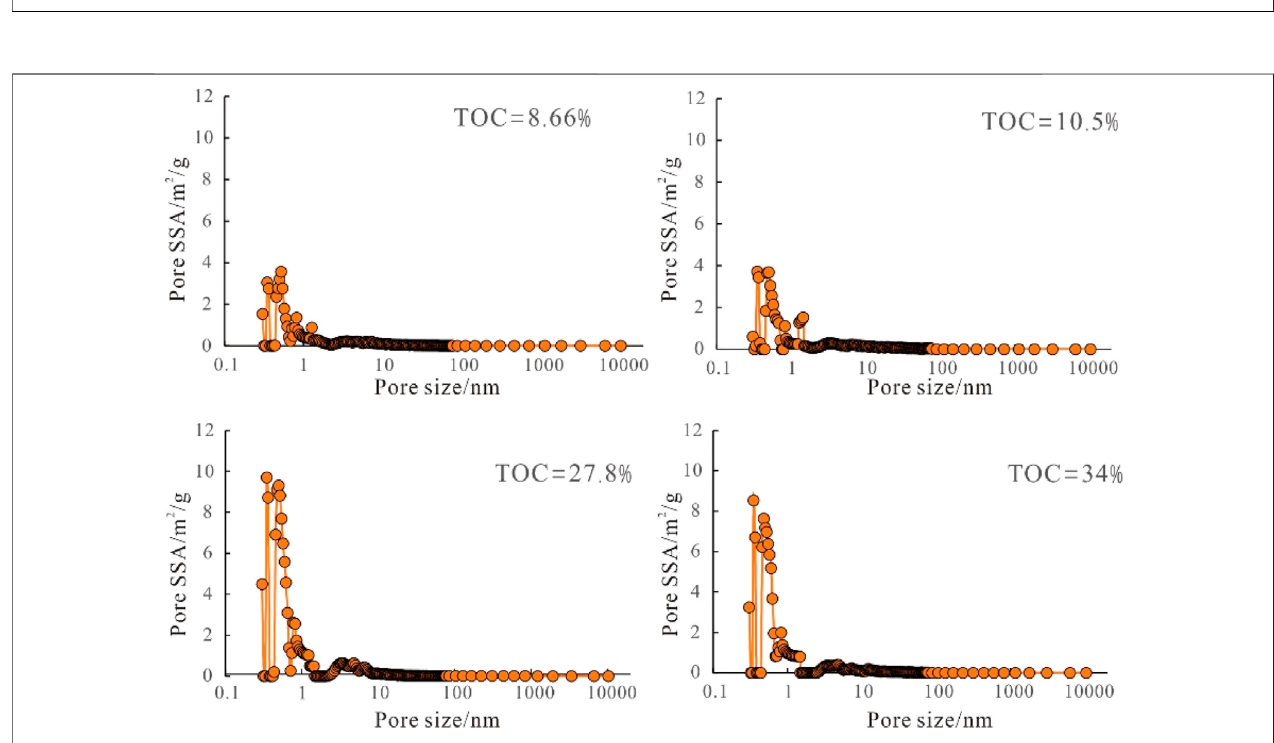
FIGURE 7 | Distribution of pore SSA over the pore size of Shan 23 shale.